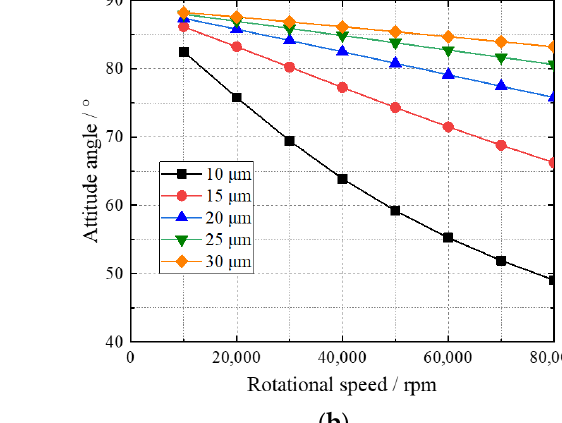
Figure 12. ( a ) Bearing load capacity and ( b ) attitude angle of hydrogen gas bearings with gas film clearance.